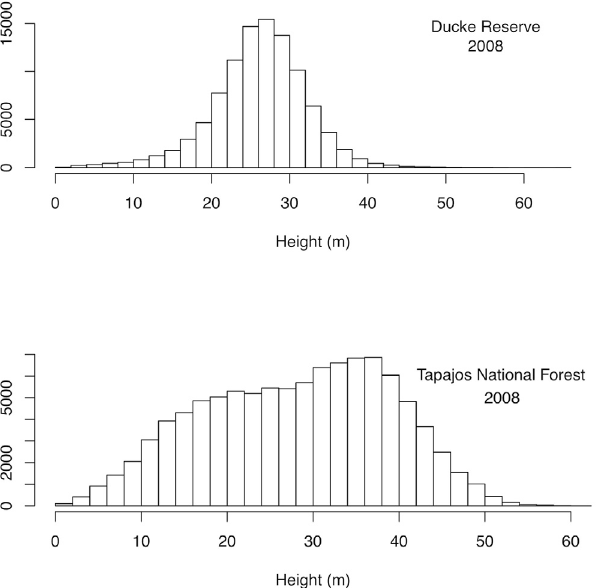
Fig 1. Distribution of canopy heights in 2008 airborne lidar acquisitions. Shown for (a) Ducke Reserve and (b) Tapajos National Forest.